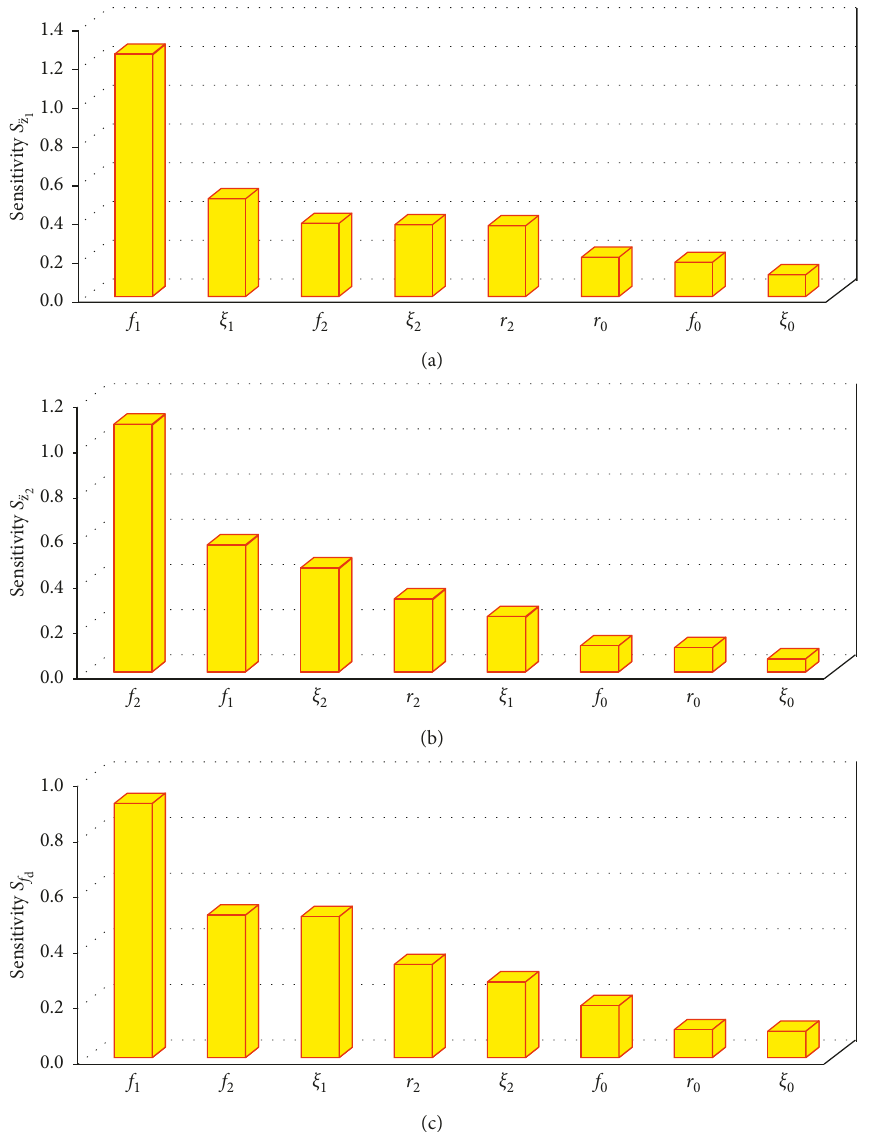
€ z 1 ; (b) the convalescent RMS ac-